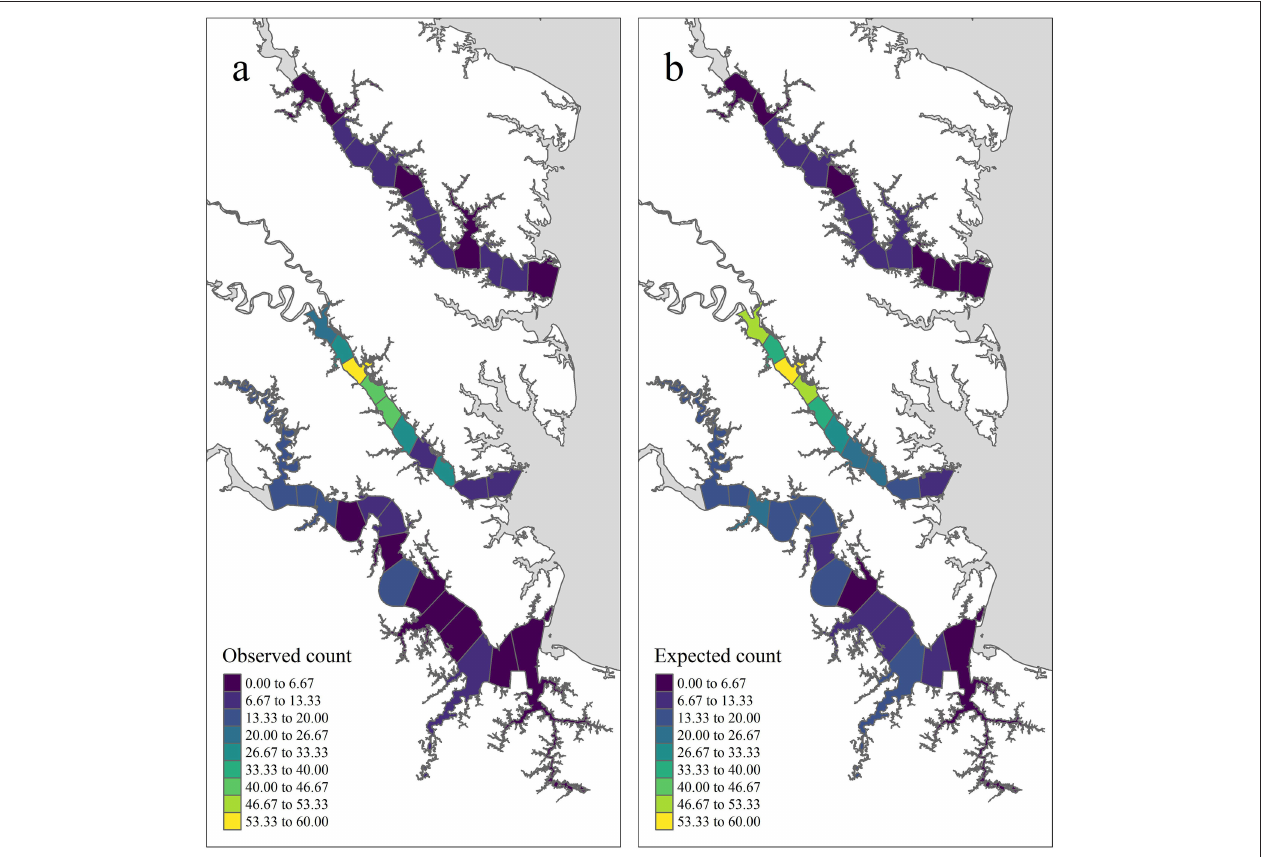
FIGURE 3 | Temporally aggregated observed and expected juvenile blue crab abundance in each tributary section based on inter-annual grand means of model quantities from years 2009–2017 and management after 2008 (see the Methods: Prioritized Areas for Conservation Section for definitions) (a) shows the mean observed juvenile blue crab abundance ( y k + ), while (b) shows the pseudo-posterior median of the expected abundance on the count scale ( µ k + ).